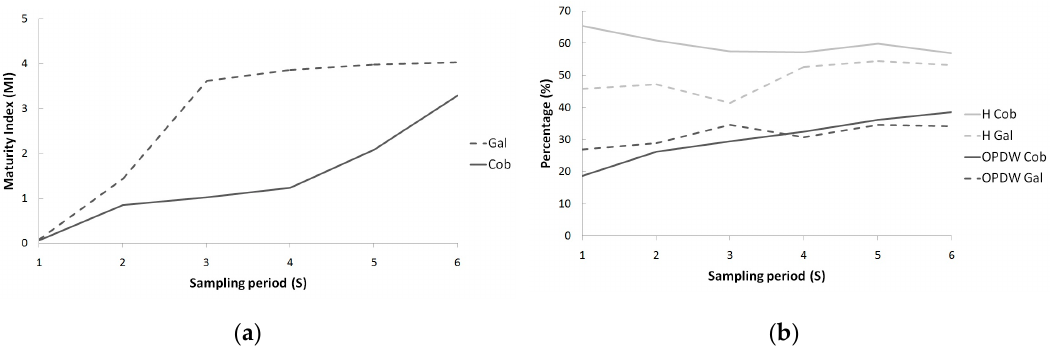
Figure 2. Maturity index (MI) evaluation ( a ), and fat content in dry matter (OPDW) and moisture (H) content evaluation ( b ) for cultivars ‘Cobrançosa’ (Cob) and ‘Galega Vulgar’ (Gal), along ripening stages (S).